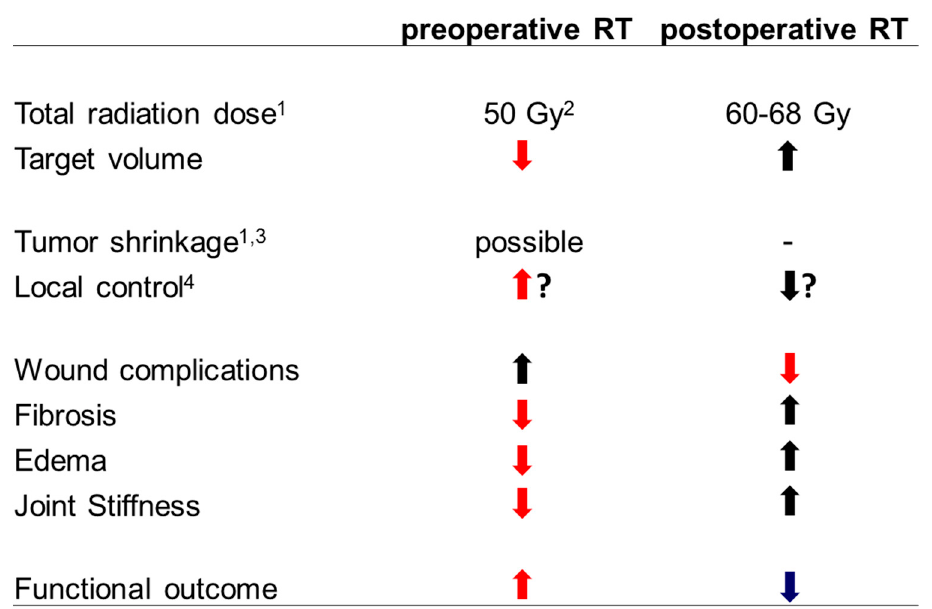
Figure 1. Pros and cons of preoperative and postoperative EBRT in extremity STS (modified from [6]). 1 For (anticipated) gross total resections without prior radiation therapy. 2 An additional preoperative or postoperative boost can be considered in selected cases. 3 Tumor shrinkage (downsizing) as volume reduction is possible according to the literature (see main text) if volume reductions transfer into improved resectability depends on the individual lesion. 4 Improved local control rates for preoperative compared to postoperative EBRT (but not vice versa) have been described in some series (see main text), although this finding is not supported by the only randomized trial.